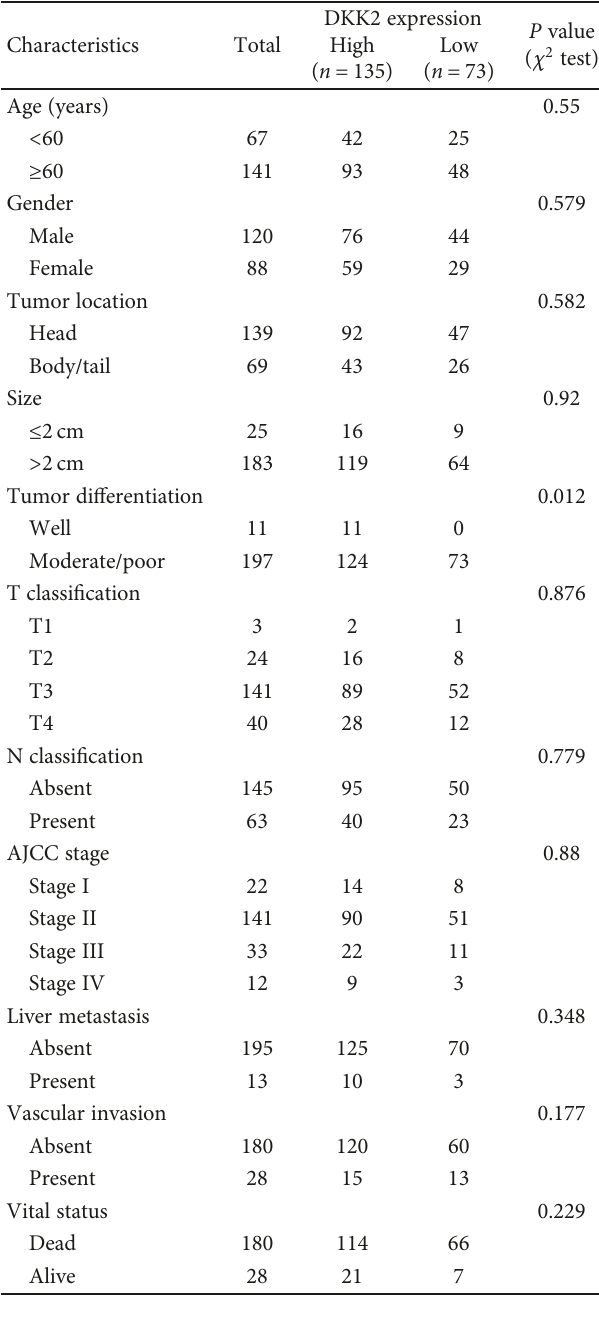
Table 1: Correlations of DKK2 with clinical characteristics in PDAC